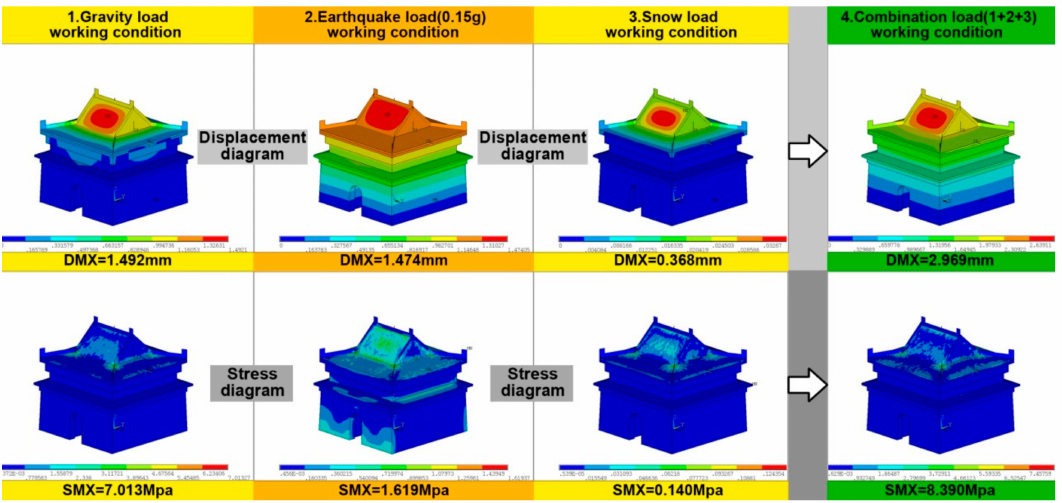
Figure 15. Displacement nephogram and stress nephogram of the Limestone Hall with an ideal status under three loads of gravity, earthquake, snow, and the combined load.